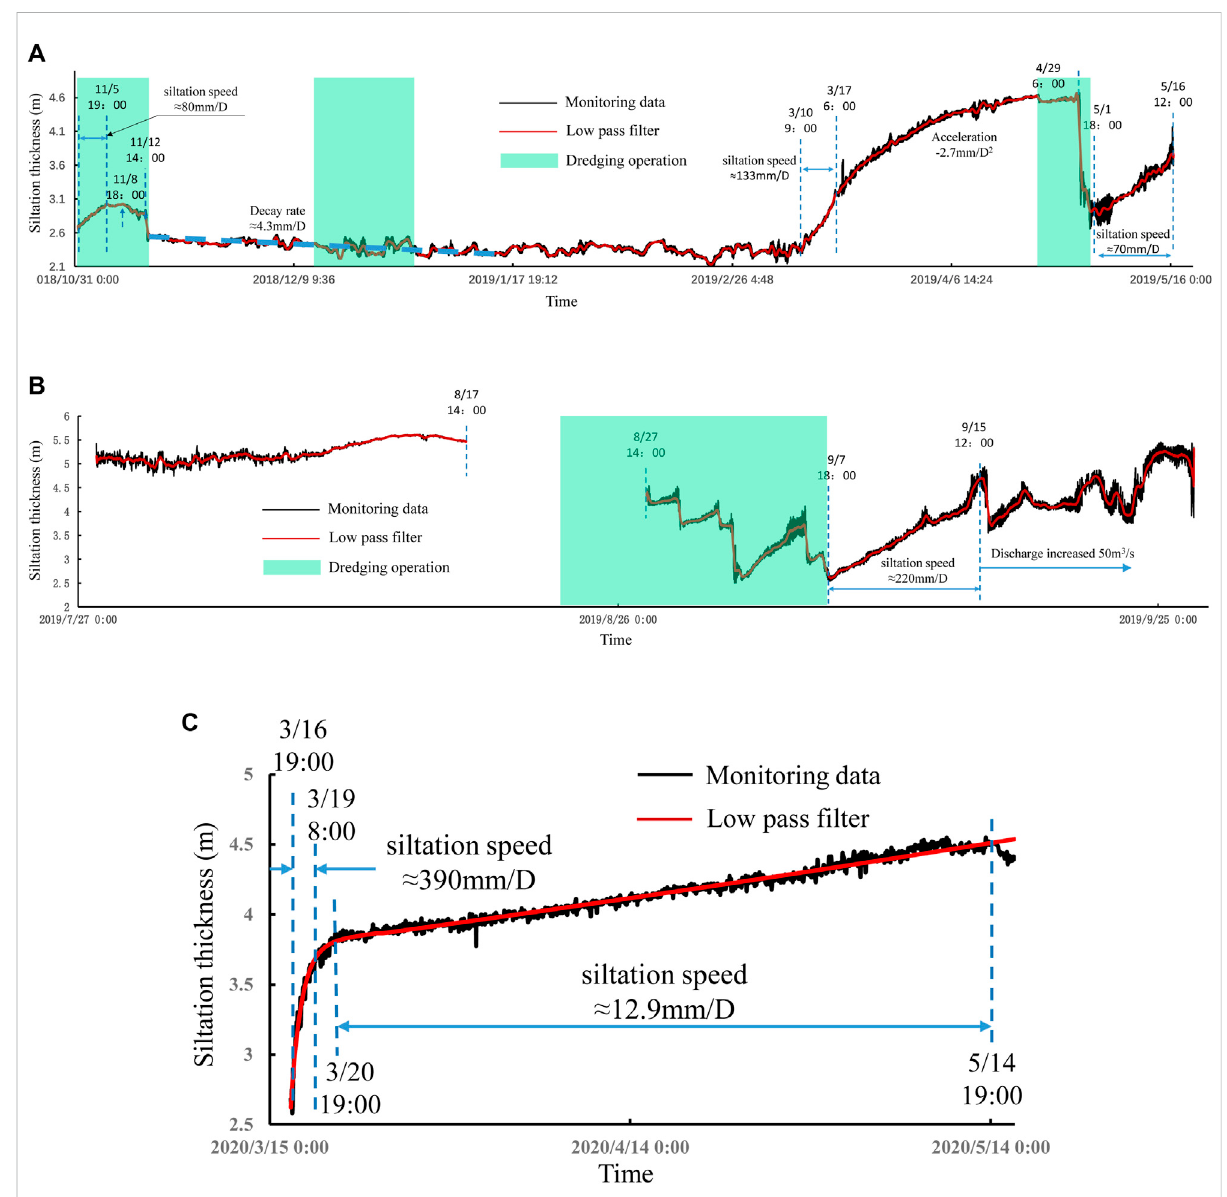
FIGURE 6 Changes in the thickness of the siltation. (A) Changes in the thickness of siltation from 31 October 2018 to 16 May 2019. (B) Changes in the thickness of siltation from 27 July 2019 to 25 September 2019; (C) Changes in the thickness of siltation from 15 March 2020 to 14 May